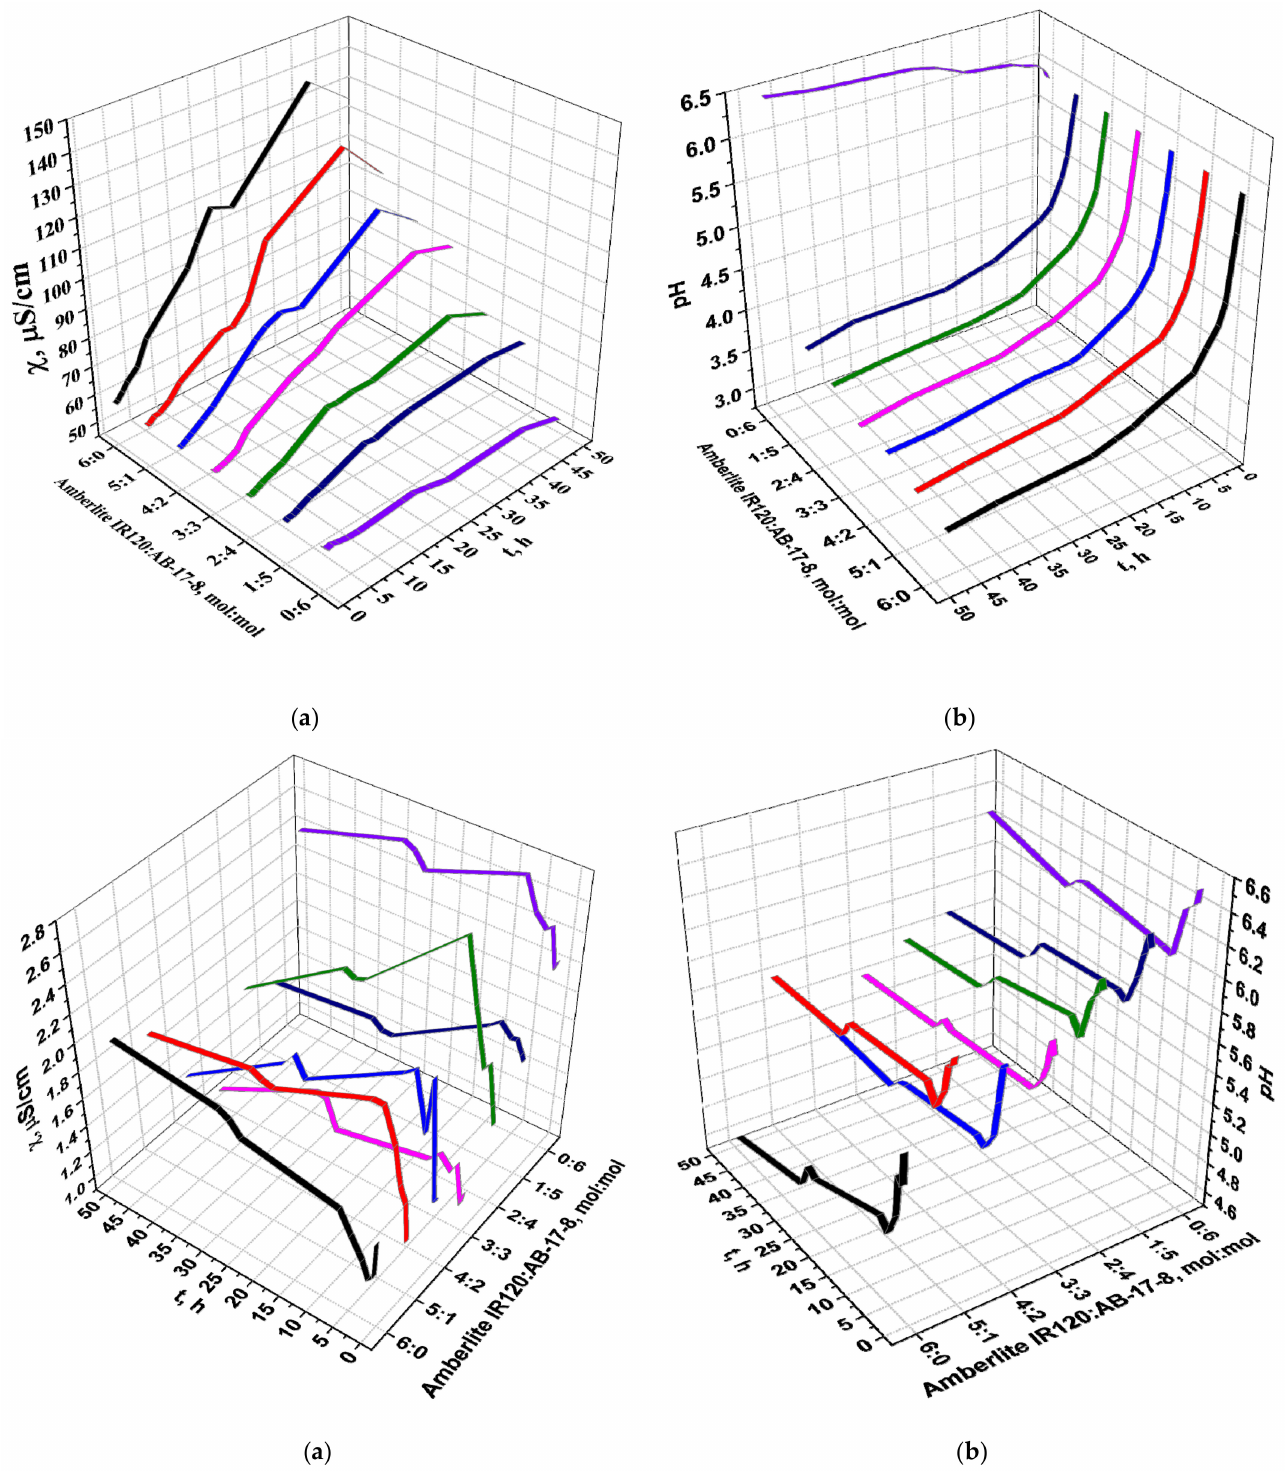
Figure 3. Specific electric conductivity and pH of neodymium sulfate ( a , b ) and scandium sulfate ( c , d ) in the presence of interpolymer system of the Amberlite